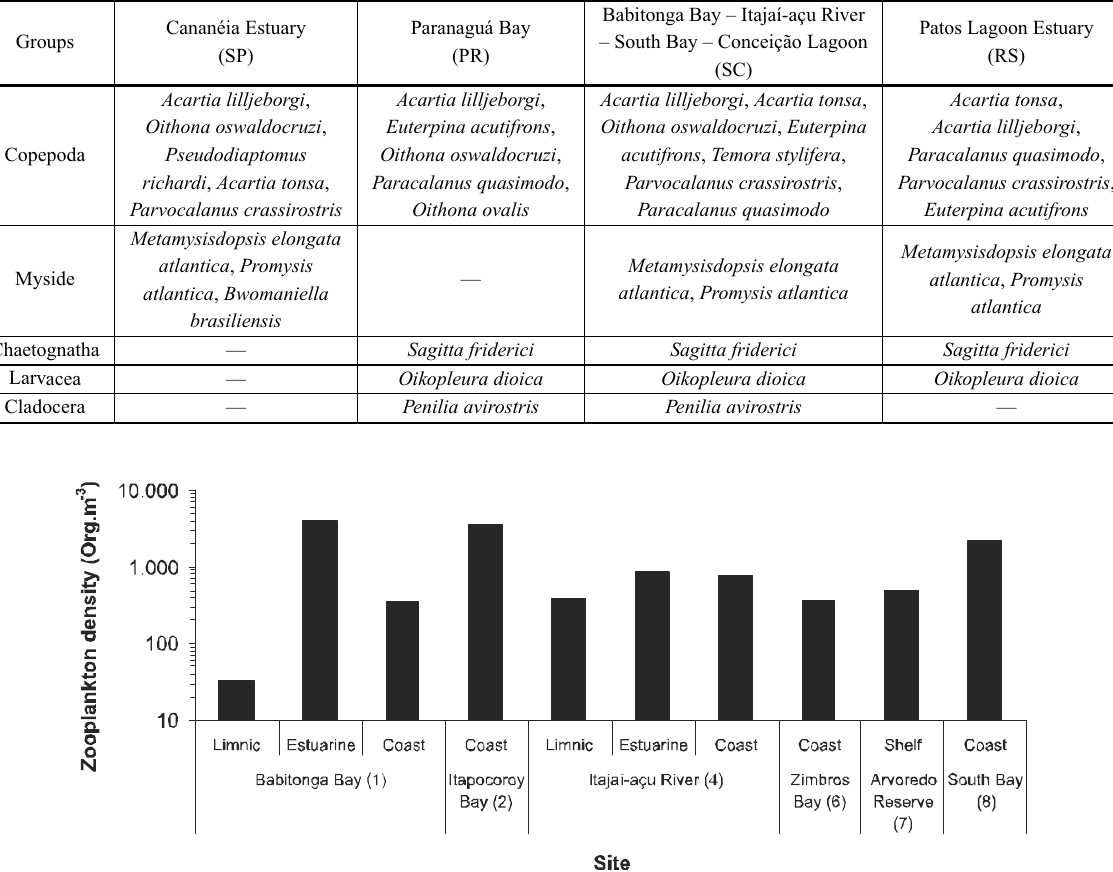
Main representatives of the zooplankton community of different estuaries of the south and southeast regions of Brazil.